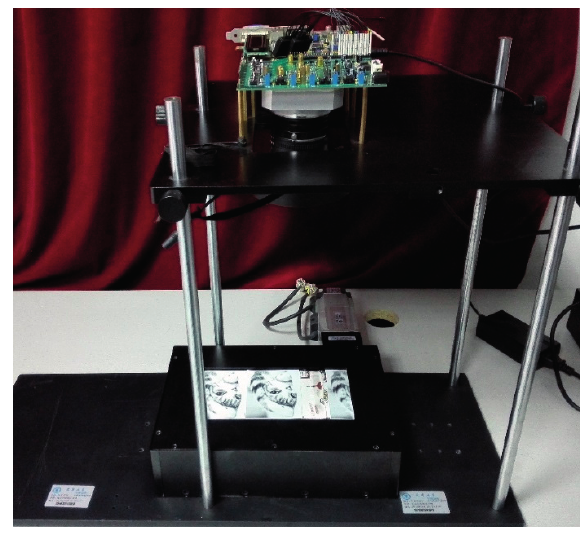
Figure 20. The prototype test platform.